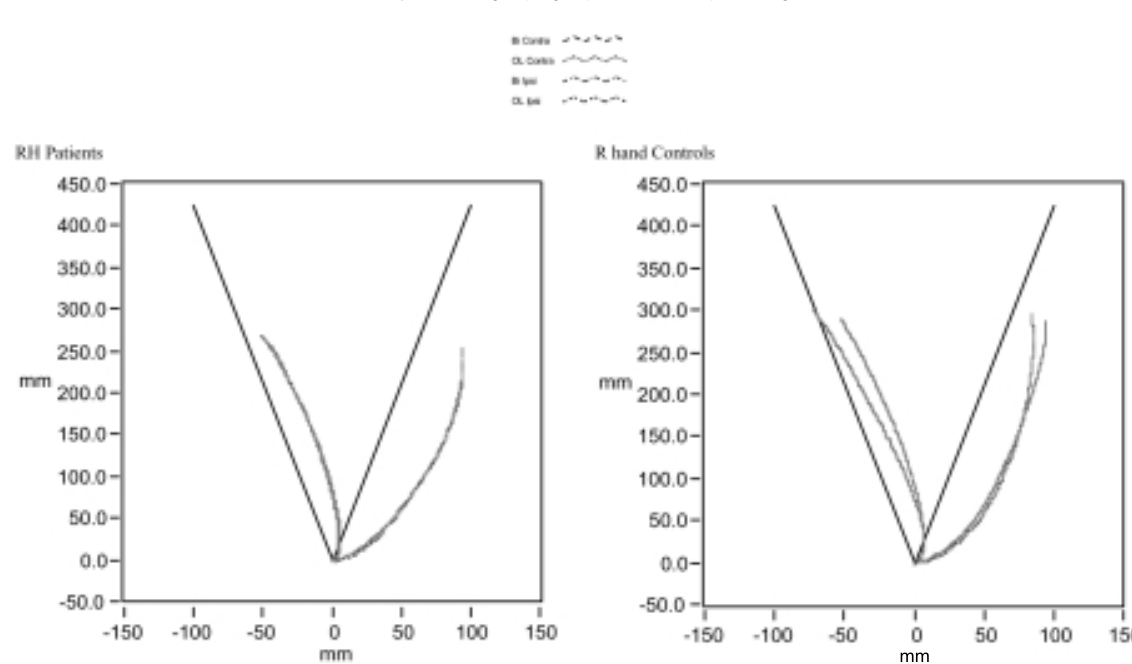
Fig. 2. Mean Hand paths for the control subjects and the R CVA patients (RH patients) plotted separately for viewing condition (Bi = Binocular, OL = Open Loop) and hemispace).